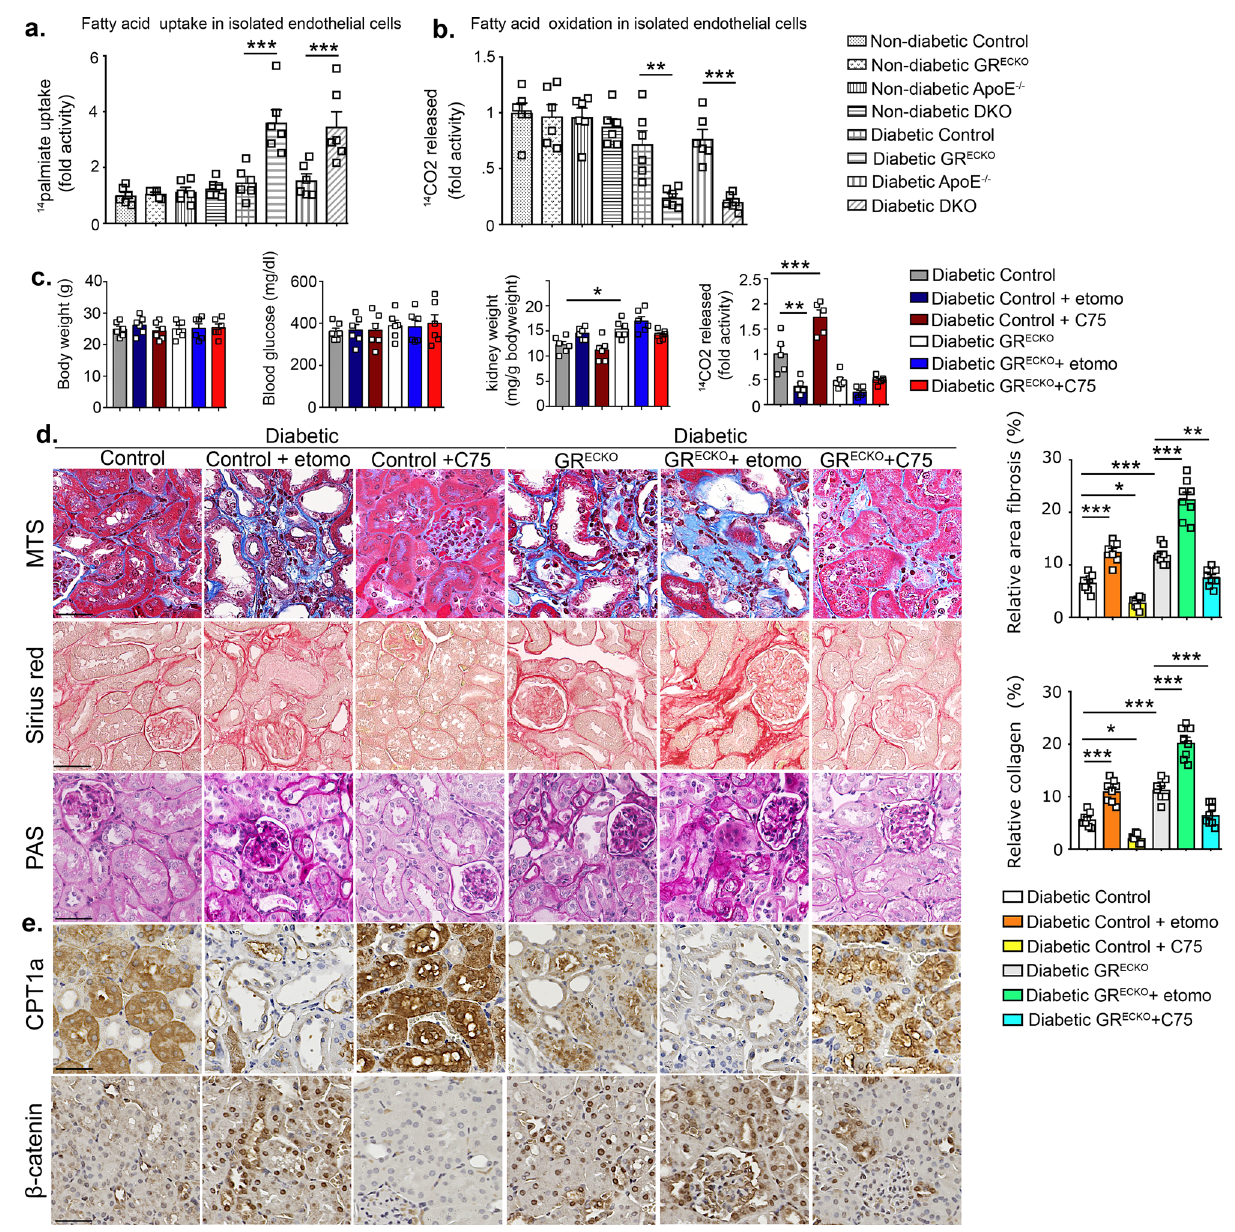
Fig. 6 Metabolic reprogramming by loss of endothelial GR loss worsens diabetic kidney disease. a Radiolabeled 14 C-palmitate uptake analysis in isolated endothelial cells from kidneys of nondiabetic and diabetic control, GR ECKO , Apoe − / − , and DKO mice. CPM of each sample were counted. Data were normalized to μ g protein. Fold activity is presented. Endothelial cells isolated and cultured from six biologically independent mice/group were performed in triplicate and analyzed for 14 C-palmitate uptake analysis. Data are mean ± SEM. b Radiolabeled [ 14 C]palmitate oxidation and [ 14 CO 2 ]release were measured in isolated endothelial cells from kidneys of nondiabetic and diabetic control, GR ECKO , Apoe − / − , and DKO mice. CPM of each sample was counted. Data were normalized to μ g protein. Fold activity is presented. Endothelial cells isolated and cultured from six biologically independent mice/ group were performed in triplicate and analyzed for 14 C-palmitate uptake analysis. Data are mean ± SEM. c Body weight, blood glucose, and kidney weight/ body weight were measured at the end of these experiments. N = 6 biologically independent mice from two experiments. Ex vivo radiolabeled [ 14 C] palmitate oxidation and [ 14 CO 2 ]release were measured in kidneys. CPM of each sample was counted. Isolated endothelial cells from fi ve biologically independent mice/group were analyzed in triplicate. Data are mean ± SEM. d Masson trichrome, Sirius red, and PAS staining were analyzed in the kidneys of control-, etomoxir-, and C75-treated diabetic mice. Representative images are shown; original magni fi cation ×300. Relative area of fi brosis (%) and relative collagen deposition (%) were measured using the ImageJ program. N = 8 biologically independent mice per/group from three independent experiments were analyzed. Scale bar 50 μ m. Data are mean ± SEM. e Immunohistochemical analysis of CPT1a and β -catenin. Representative images are shown; original magni fi cation ×300. Scale bar 50 μ m. N = 6 biologically independent mice per group from three independent experiments. For all panels one-way ANOVA with Tukey post-test was used for the analysis of statistical signi fi cance. Signi fi cance * p < 0.05, ** p < 0.01, *** p < 0.001. Source data are provided in the source data fi